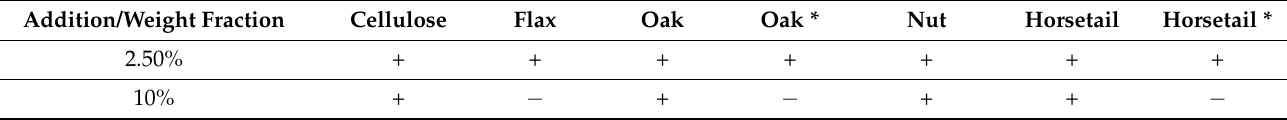
Figure 2. Stages of composite production. Table 1. Summary of the obtained